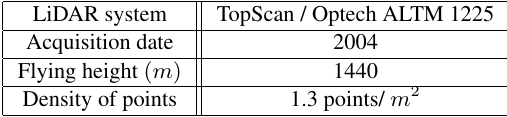
Table 4: Characteristics of the LiDAR datasets.